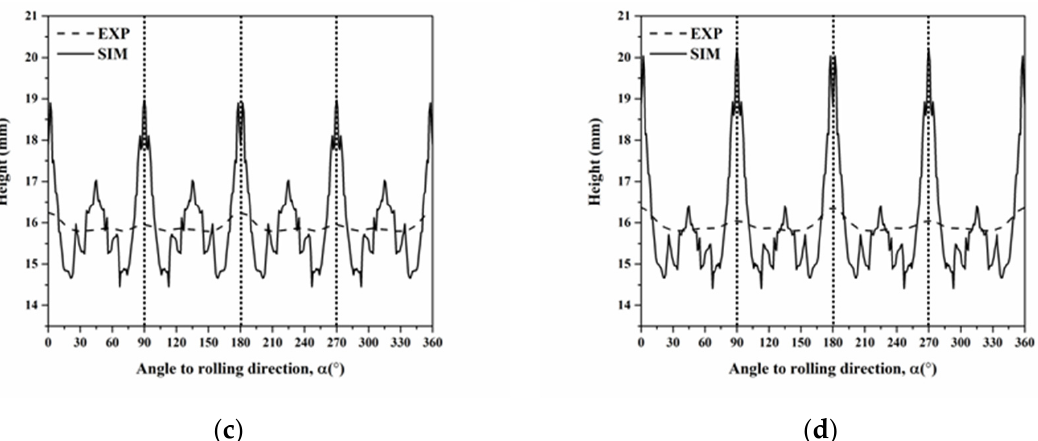
Figure 15. Cup height profiles as a function of the angle in AA5151 alloy at 250 °C for ( a ) 0.5, ( b ) 1, ( c ) 2, and ( d ) 3 h using six components considering the multi-slip systems without orientation spread (Dashed and continuous lines mean experiment and simulation, respectively).